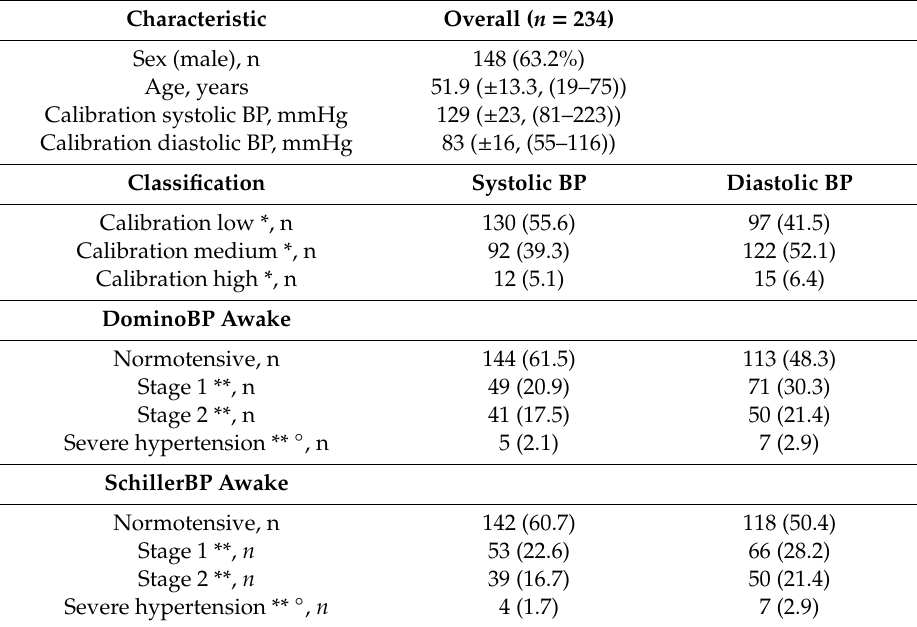
Table 2. Baseline characteristics for all